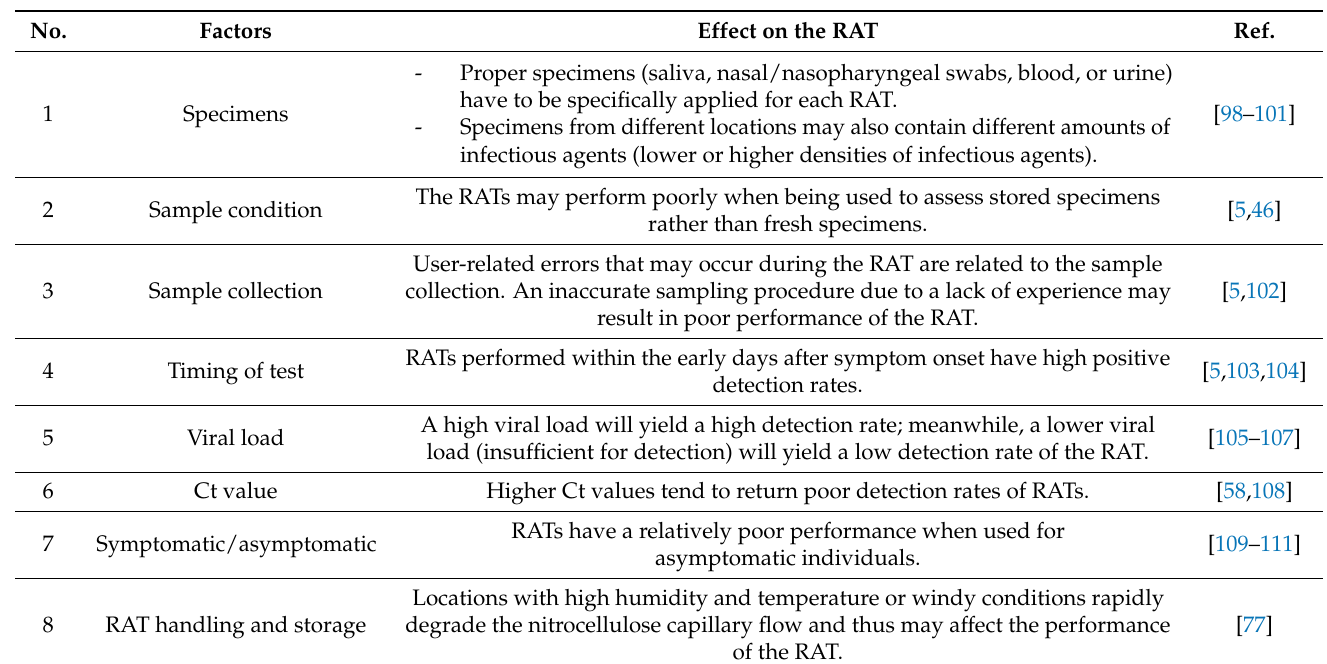
Table 3. The factors that affect the performance of